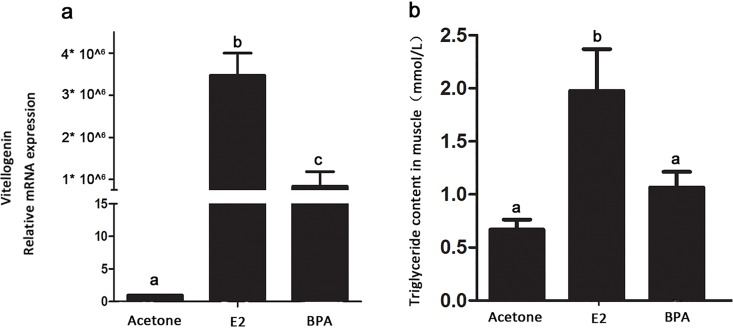
Two indices of the host evaluated the vitellogenin and triglyceride content in male zebrafish.a) The mRNA relative expression of VTG by E2 and BPA in male zebrafish liver. b) The triglyceride content in male zebrafish in muscle. Statistical analysis was carried out using one-way ANOVA. Different lower case letters represent significant differences among treatments (P< 0.05).